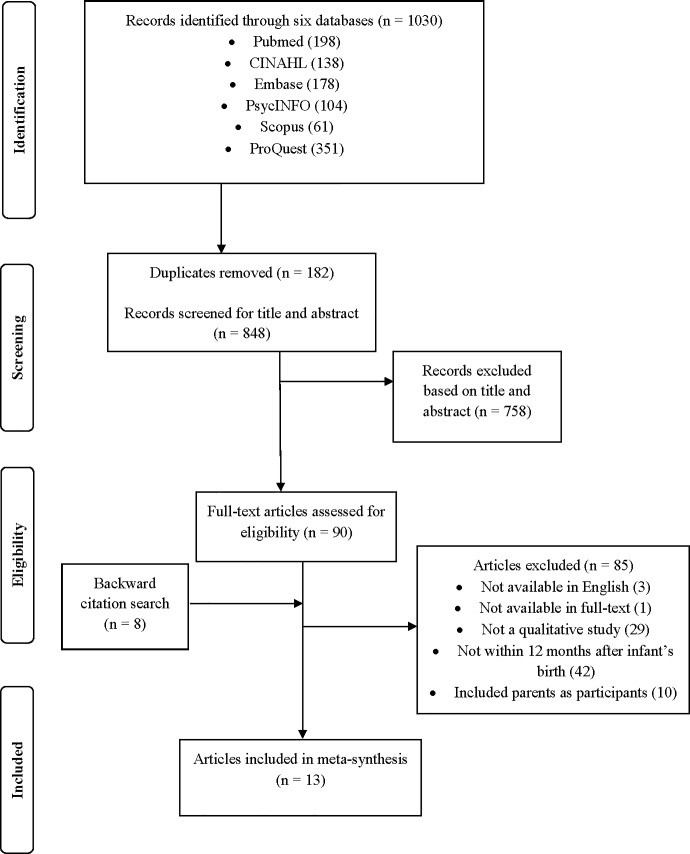
PRISMA flow diagram.